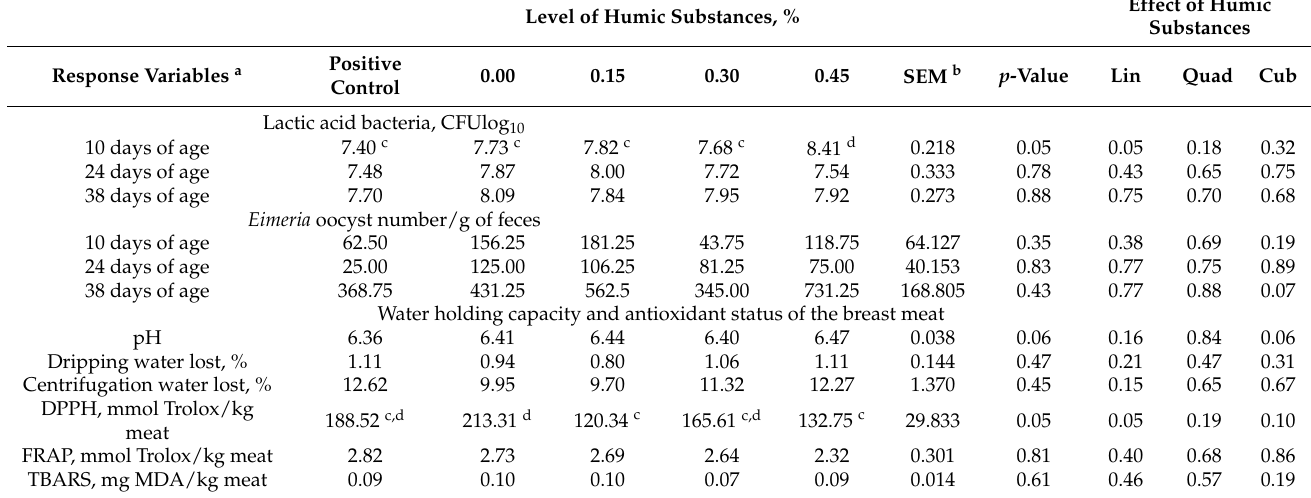
a Data are means of eight replications per treatment with pooled data of three birds in each replication. b Standard error of the mean. c,d Values within rows with different superscripts differ significantly, p < 0.05. DPPH = Scavenging activity of 1,1-diphenyl-2-picrylhydrazyl radicals; FRAP = antioxidant power of ferric radicals; TBARS = thiobarbituric acid-reactive